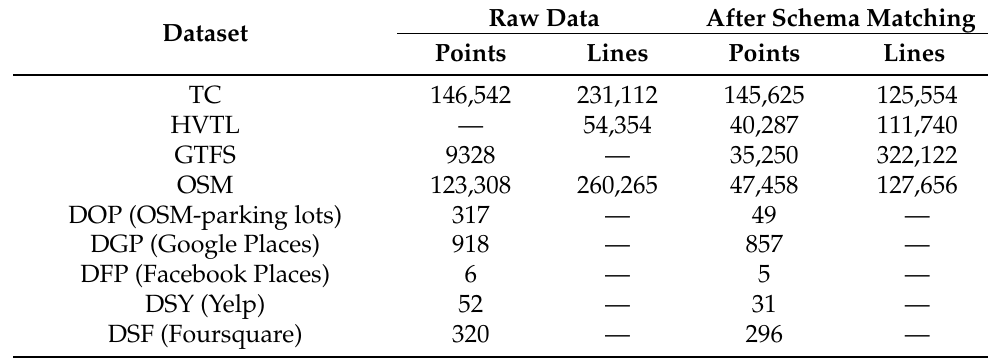
Table 1. The number of points and lines from datasets before and after schema matching procedures.